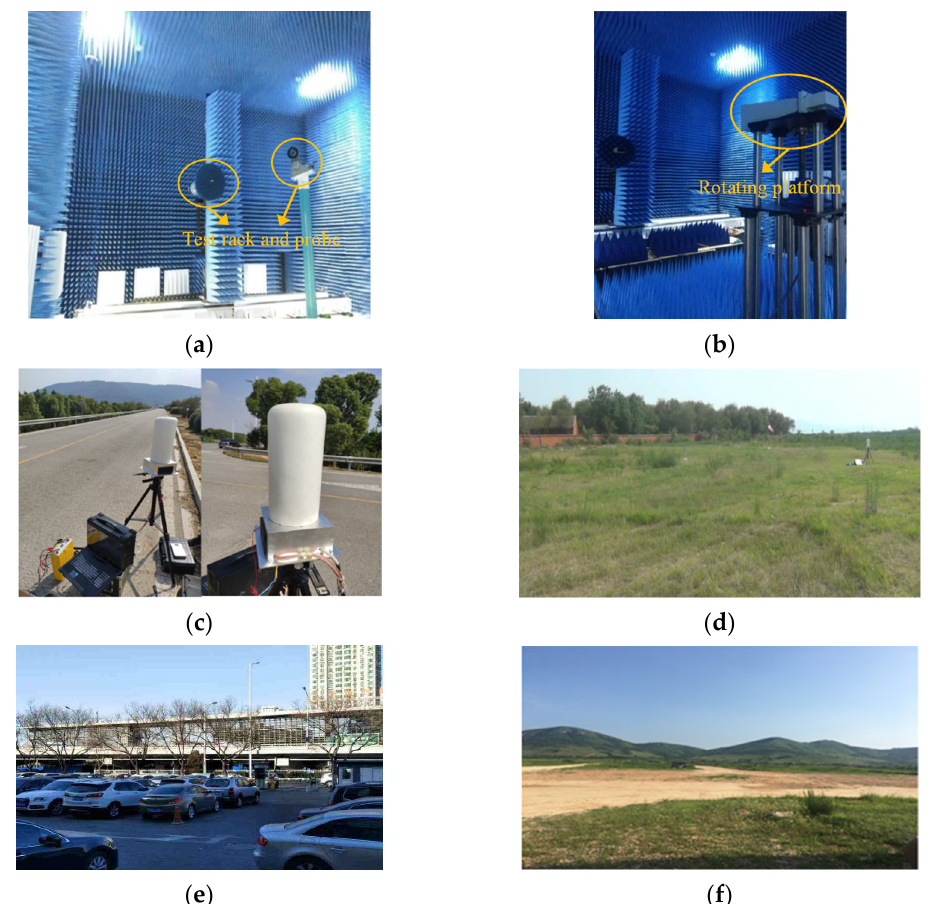
Figure 2. UCA radar data collection for different scenarios: ( a ) Microwave anechoic chamber test rack and probe; ( b ) Microwave anechoic chamber rotating platform; ( c ) Highway; ( d ) Dry grassland; ( e ) Town; ( f ) Gravel land.